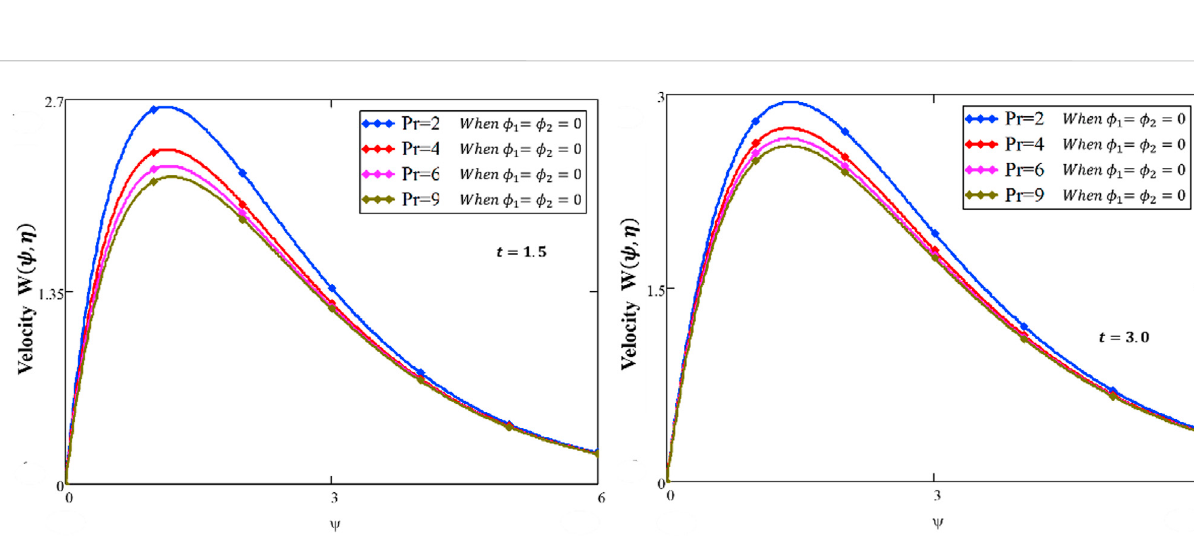
FIGURE 7 Simulation to explain the velocity for changing Pr when α (cid:3) 0 . 5 , Gr (cid:3) 8 , Gm (cid:3) 6 . 5 , Sc (cid:3) 0 . 5 , λ 1 (cid:3) 0 . 5 , and λ 1 (cid:3) 0 .